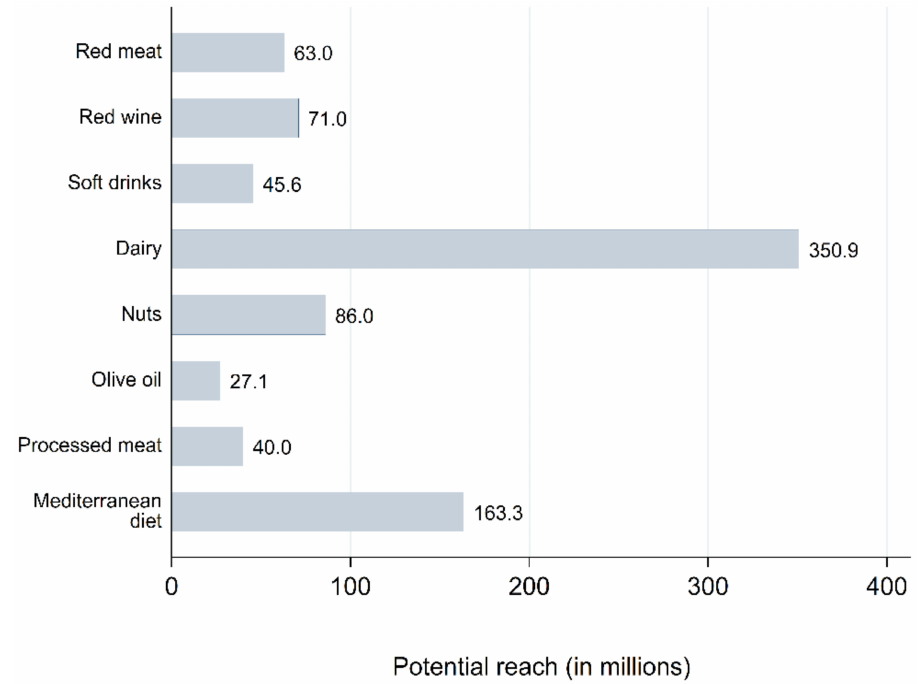
Figure 1. Potential reach (potential audience) of each food group analyzed. Potential reach is defined as a numerical value measuring the potential audience of the hashtag. Regarding the sentiment analyses (Figure 2), all components analyzed obtained a score between 40 and 60, which is considered neutral, except for red wine that scored above 60. None of the hashtags analyzed obtained a negative score.